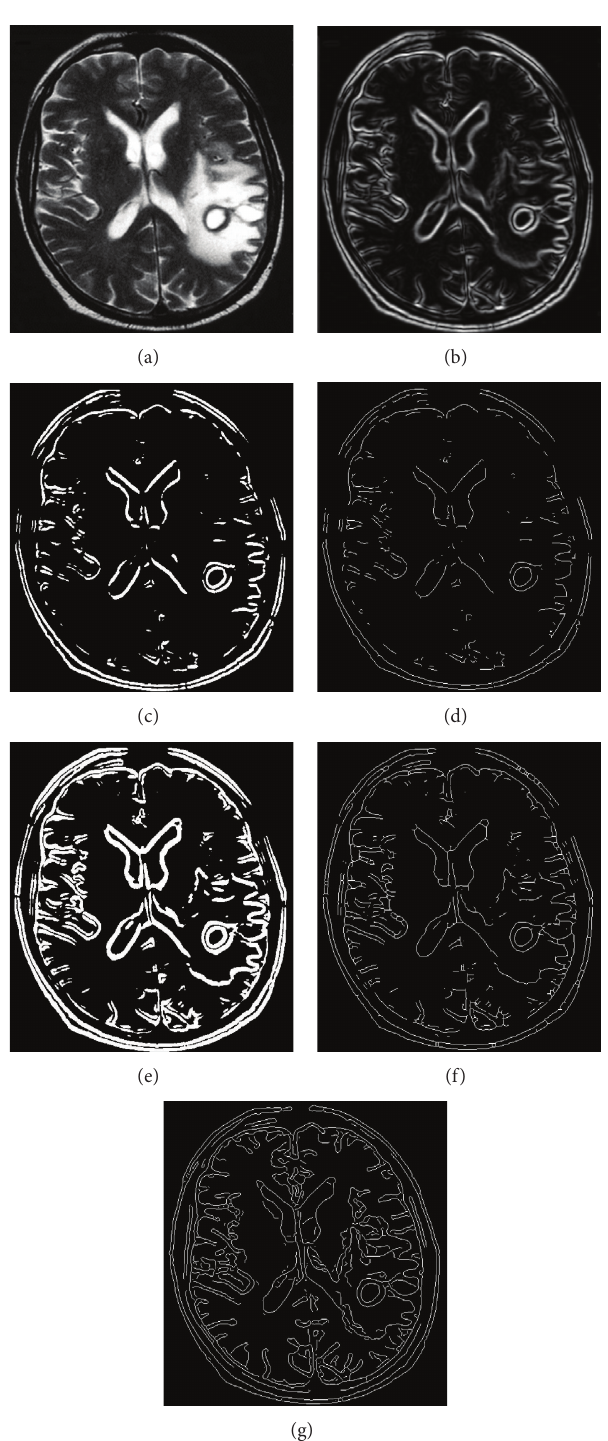
Figure 6: Edges of a CT scan brain image (𝜎 = 0.3 and 𝜔 = 0.05) ; (a) original, (b) GWT, (c) 𝑘 -means, (d) skeleton of (c), (e) FCM, (f) skeleton of (e), and (g)